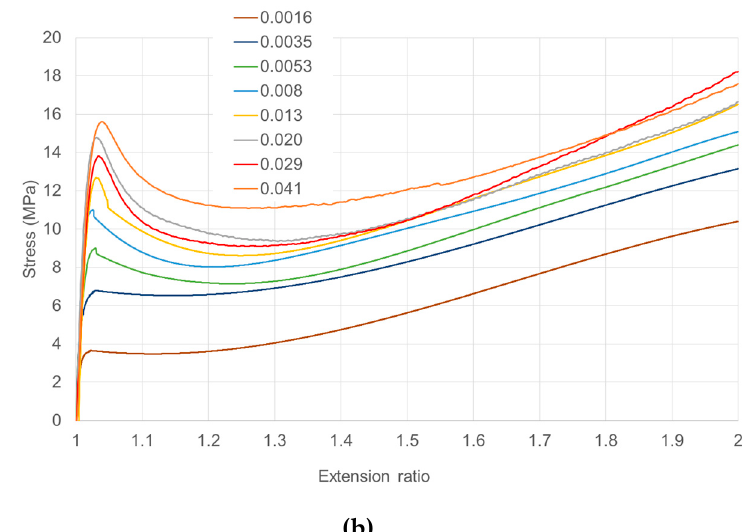
Figure 2. ( a ) Stresses in loading at a range of loading strain rates followed by stress relaxation at constant extension ratio 2. ( b ) Stresses in loading plotted against extension ratio. Octahedral strain rates (Equation (4)) are specified in s − 1 in the captions. Times of loading range from 17.2 s at 0.041 s − 1 to 442 s at 0.0016 s − 1 .